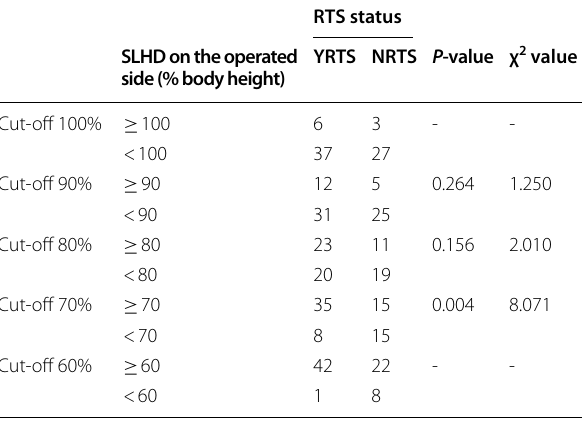
Table 3 Relationship between return-to-sports status and single-leg hop for distance on the operated